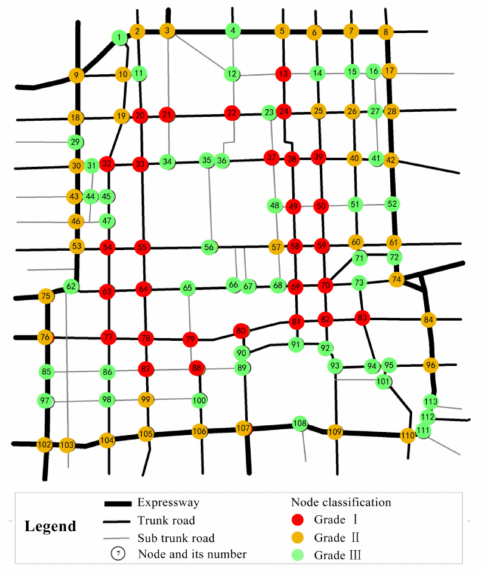
Figure 11. Spatial distribution of node classification.